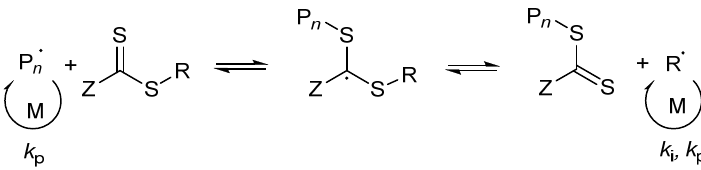
Figure 9. Illustration of the pre-equilibrium of the RAFT mechanism.